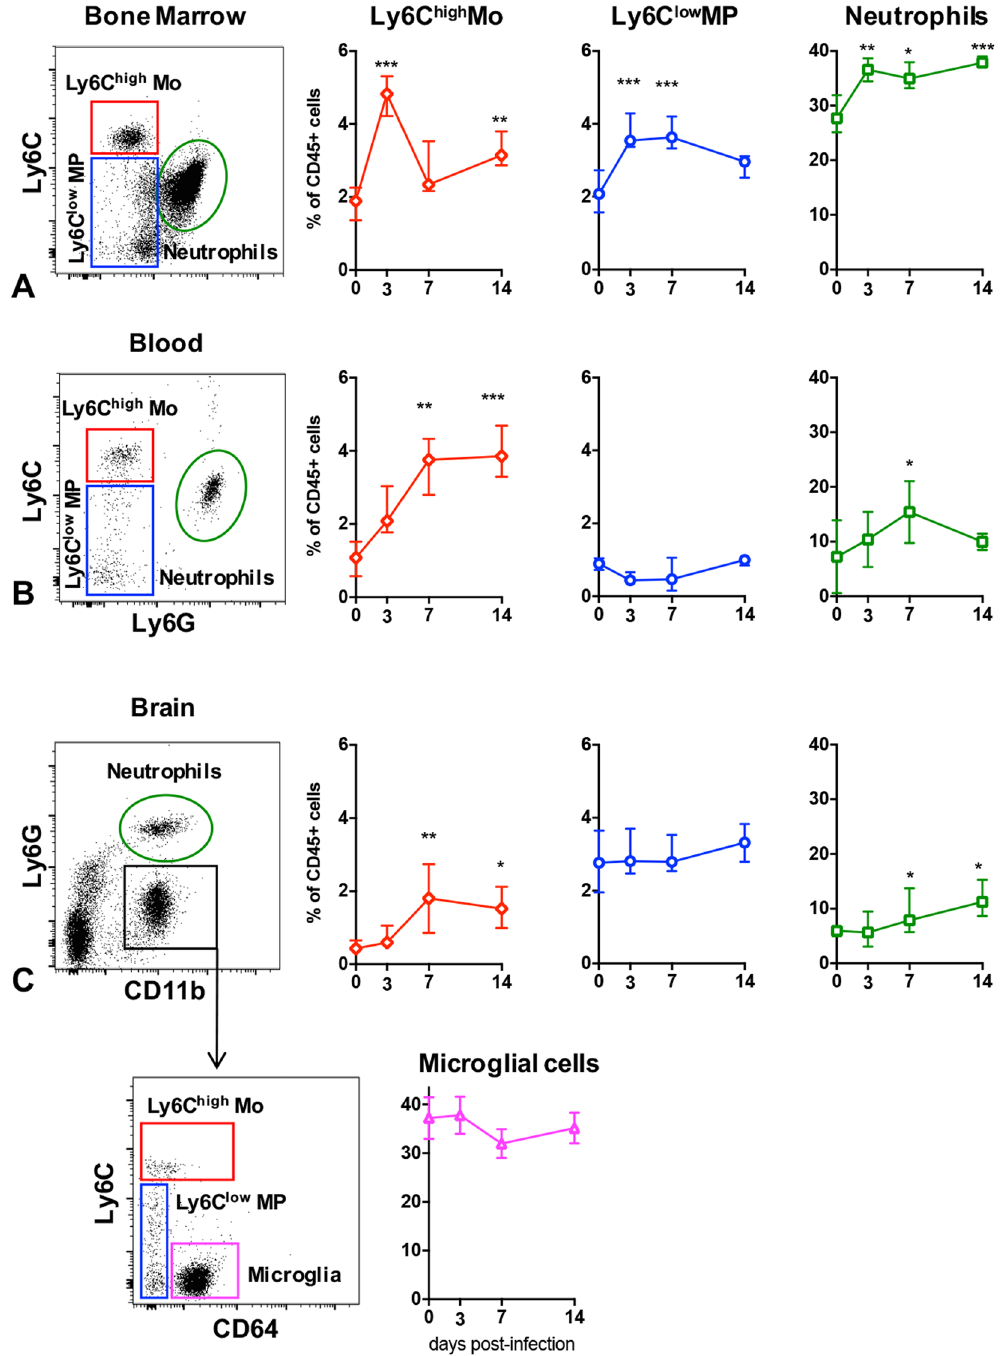
Figure 3. Myeloid cells dynamics in the bone marrow ( A ), blood ( B ) and brain ( C ) of BALB/c mice infected with Leishmania donovani . Dot plots and variations of inflammatory monocytes (CD45 + CD11b + Ly6C high ), patrolling anti-inflammatory monocytes (CD45 + CD11b + Ly6C low ), neutrophils and microglial cells at days 3, 7 and 14 p.i. Data are represented as median and the interquartile range. * Indicates P <